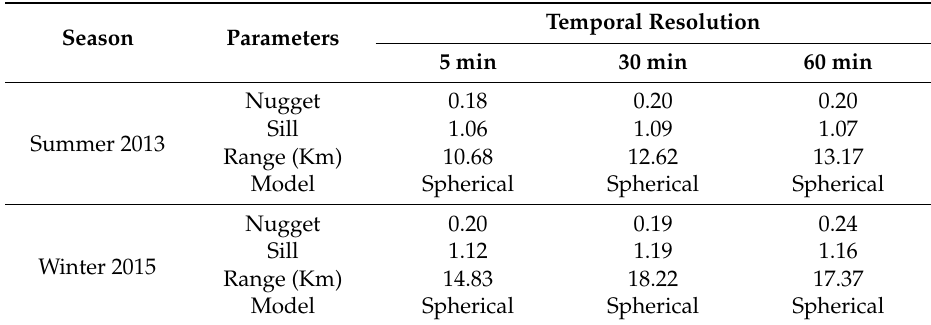
Table 4. The parameters of the theoretical models used in Ordinary Kriging (OK), Kriging with an External Drift (KED), and Conditional Merging (CM).